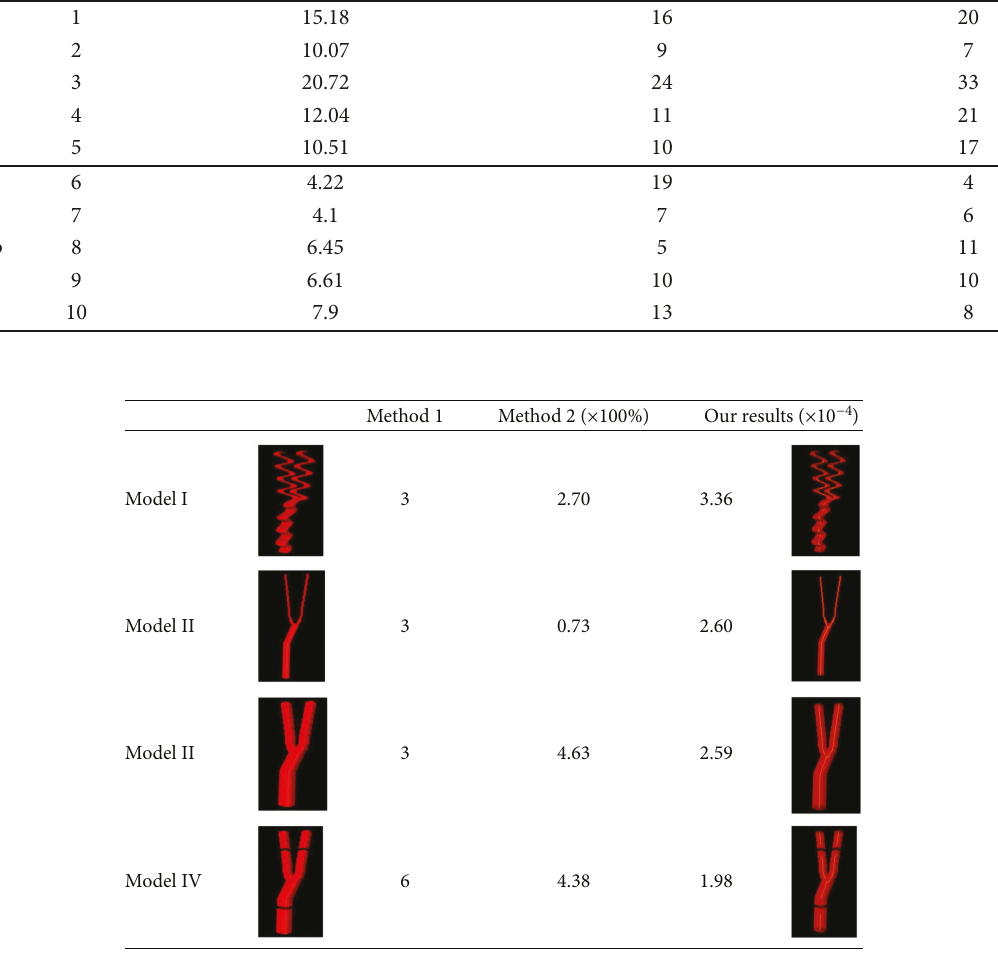
Figure 7: The 3D MVD parameters from three